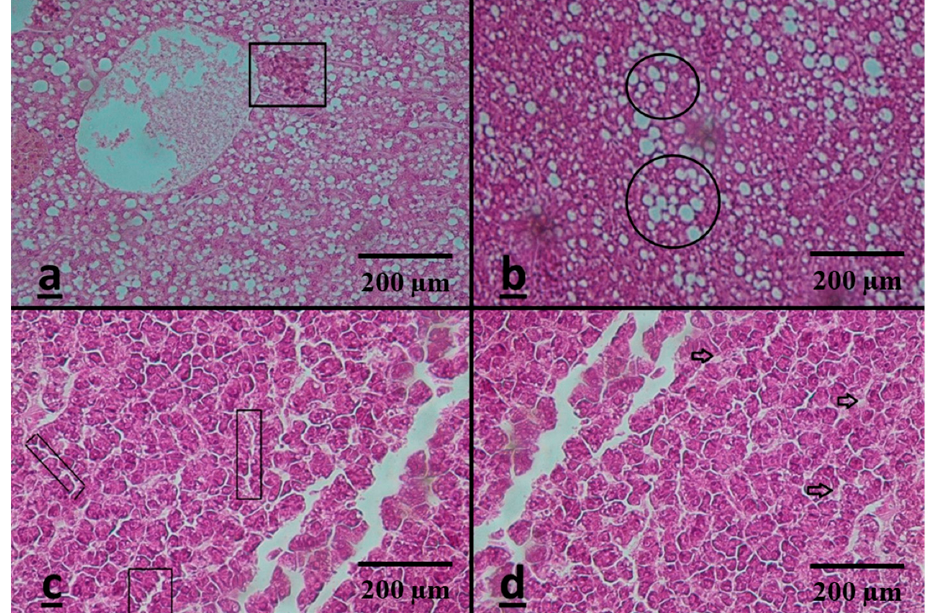
Figure 3. ( a – d ) Liver lesions of Capoeta ( Capoeta capoeta ) 96 h after exposure to different levels of Ag-NPs; ( a ) macrophage aggregates (Ag-NPs were 5 mgL − 1 —magnified ×40); ( b ) fatty liver (Ag-NPs were 10 mgL − 1 —magnified ×40); ( c ) dilation of sinusoid (Ag-NPs were 15 mgL − 1 —magnified ×40); ( d ) necrosis (Ag-NPs were 15 mgL − 1 —magnified ×40).